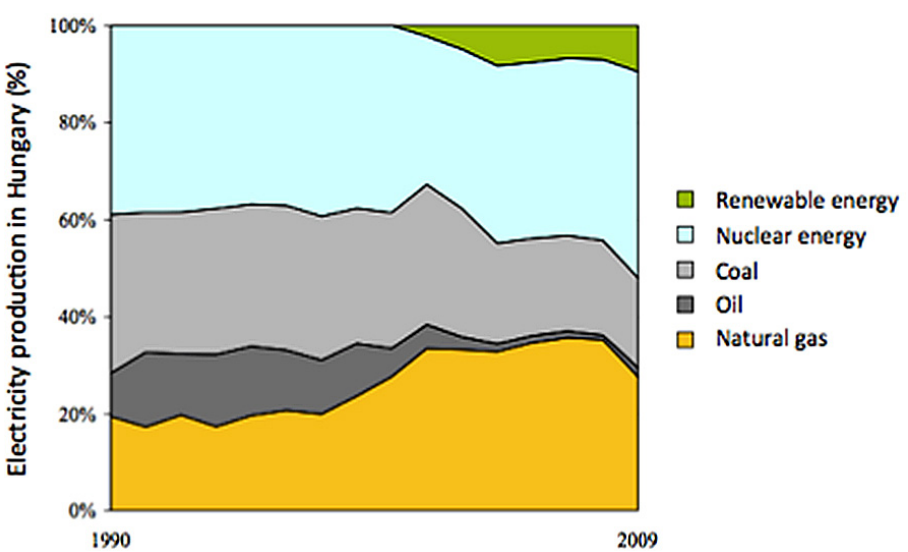
Figure 4. The structure of electricity production in Hungary [46].